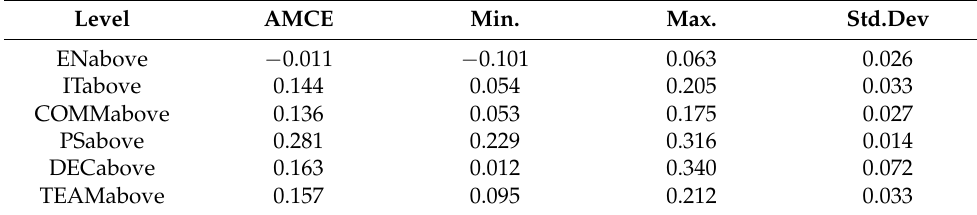
Table 1. Average marginal component effects. Level AMCE Min. Max.